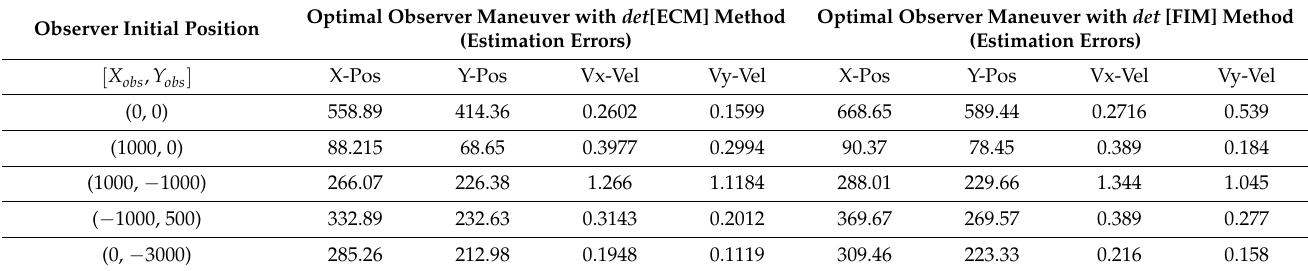
Table 2. Comparison of EKF based Optimal Observer Maneuver using ECM and FIM method.